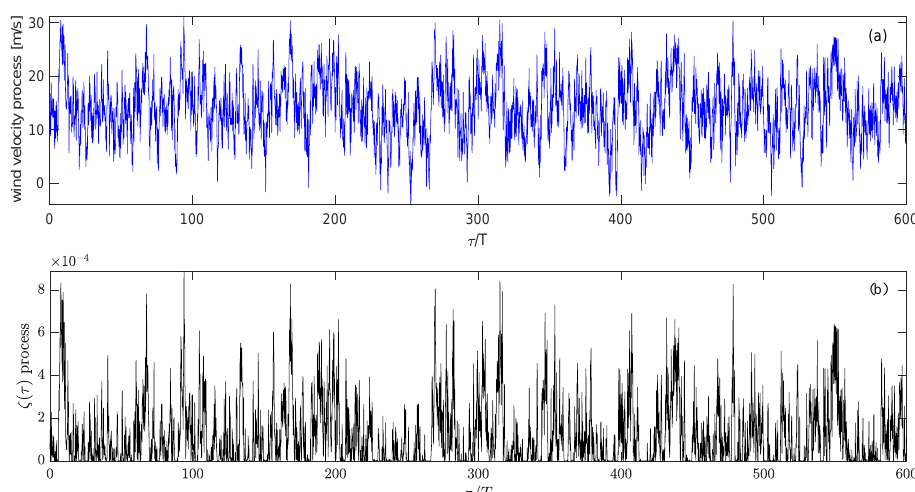
Figure 11. Wind velocity process and corresponding time dependent random forcing process ζ ( τ ) for V m = 14 m/s and σ v = 10 m/s.